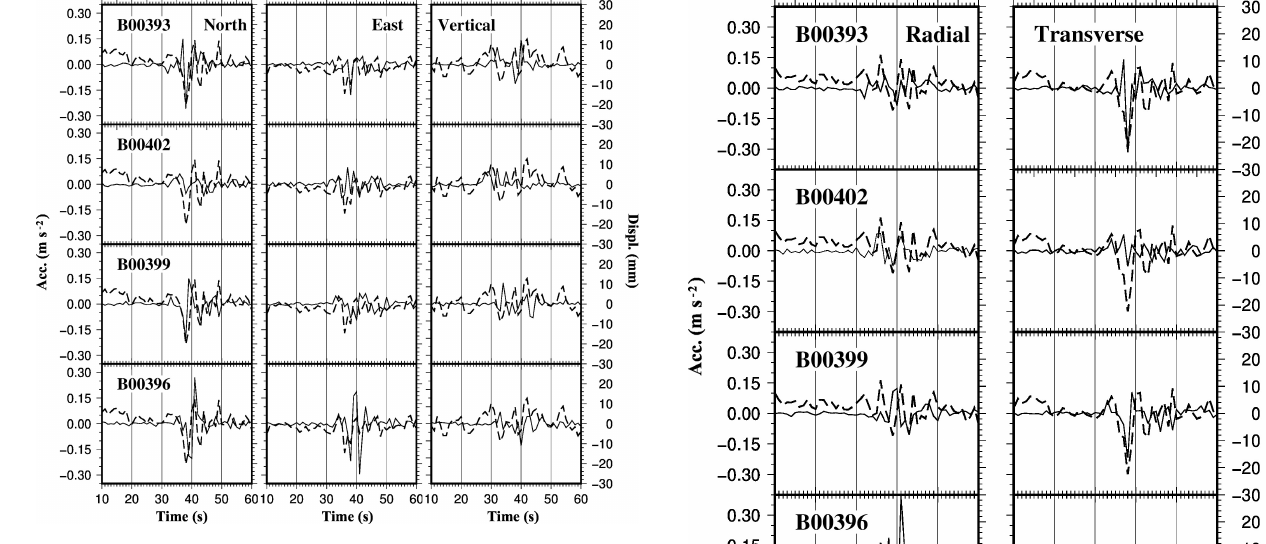
Figure 6. GPS-derived displacement waveform recorded at the Foligno permanent station (thick dashed line) and low-cost MEMS array signals (thin solid line). Observations are presented for the three local geodetic components: North, East and Vertical, with the same sampling rate of 1Hz. The MEMS instrument code is reported in each figure. The horizontal axis is given in seconds after the main shock origin time: 01:36:32UTC of 24 August 2016. The right ver- tical axis denotes GPS displacements, while accelerations refer to the left axis. According to the epicentral distances, the MEMS sig- nals of the four stations are arranged in decreasing order from top to bottom. (Built with the Generic Mapping Tool software GMT – Creative Commons Attribution 4.0 License.)